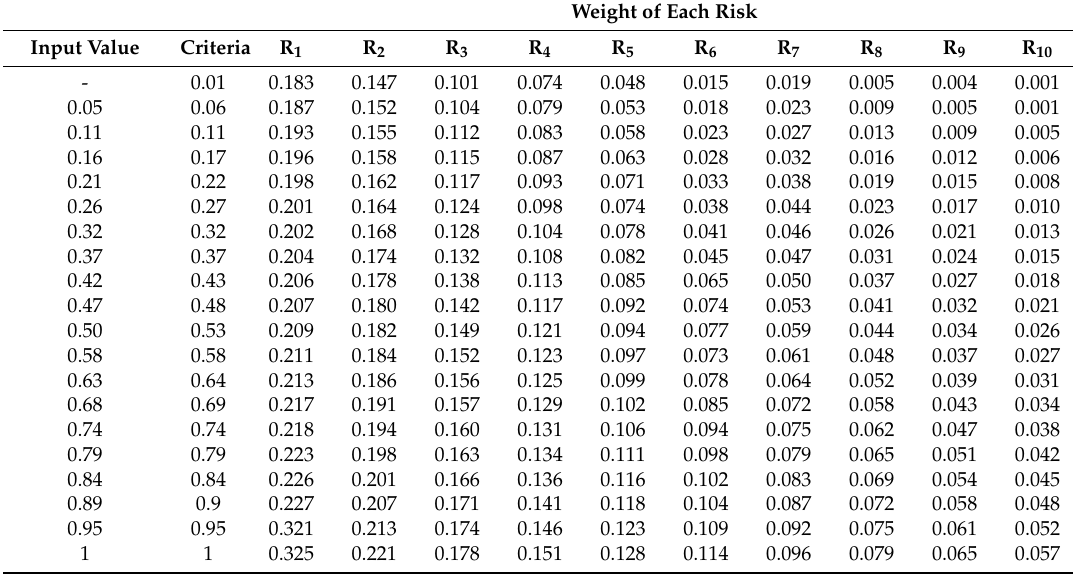
Table 10. Various values of the sensitivity analysis for each risk using the COPRAS method. Weight of Each